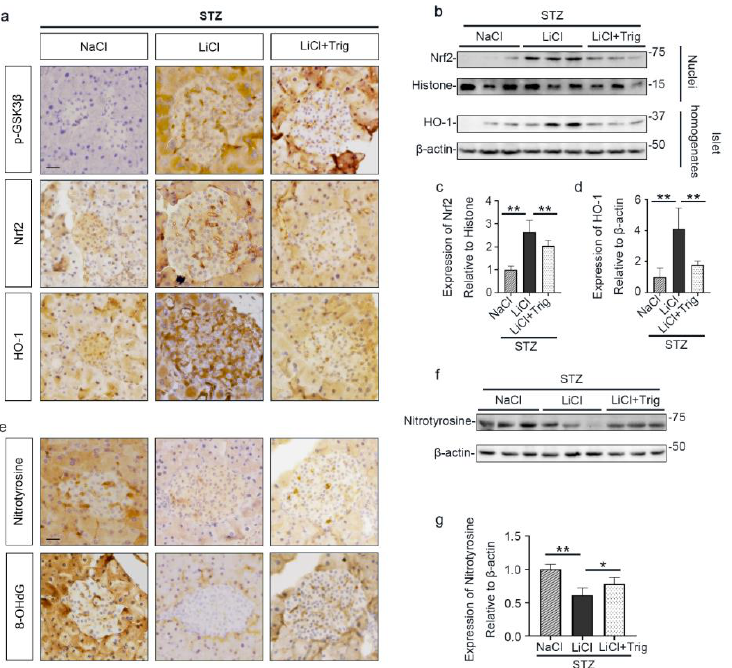
Figure 6. Nrf2 activity is required for the lithium reinforced antioxidant response to STZ injury in pancreatic islets. Animals were treated as elaborated in Figure 5. ( a ) Formalin-fixed, paraffin-embedded pancreas sections were processed for peroxidase immunohistochemical staining for p-GSK3β, Nrf2 and HO-1. Trig cotreatment barely affected the LiCl-induced p-GSK3β. Nuclear accumulation of Nrf2 and the expression of HO-1 in islet were augmented in the LiCl group, as compared with the NaCl group after STZ injury. This effect was significantly offset by Trig treatment. Scale bar = 20 µm. ( b ) Isolated pancreatic islets and their nuclear fractions were processed for immunoblot analysis for indicated molecules. ( c ) The abundance of Nrf2 in islet nuclei was determined by densitometric analysis of immunoblots as relative levels normalized to histone. Data were expressed as fold changes over NaCl group and presented as mean ± SD; ** p < 0.01 ( n = 5). ( d ) The abundance of HO-1 in pancreatic islets was determined by densitometric analysis of immunoblots as relative levels normalized to β-actin. Data were expressed as fold changes over NaCl group and presented as mean ± SD; ** p < 0.01 ( n = 5). ( e ) Formalin-fixed, paraffin-embedded pancreas sections were subjected to peroxidase immunohistochemical staining for nitrotyrosine and 8-OHdG. Scale bar = 20 µm. ( f ) Representative Western blot analysis of isolated pancreatic islets for indicated molecules. ( g ) The abundance of nitrotyrosine in pancreatic islets was determined by densitometric analysis of immunoblots as relative levels normalized to β-actin. Data were expressed as fold changes over NaCl group and presented as mean ± SD; * p < 0.05, ** p < 0.01 ( n = 5). Abbreviations: 8-OHdG, 8-hydroxy-2′-deoxyguanosine; HO-1, heme oxygenase 1; Nrf2, nuclear factor erythroid 2-related factor 2; p-GSK3β, phosphorylated GSK3β at serine